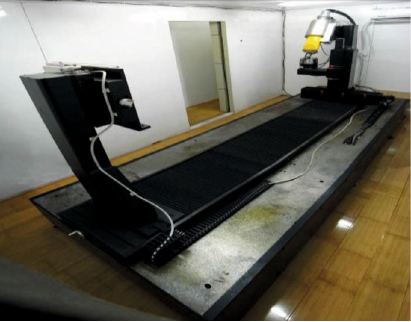
Figure 2: High-resolution micro-CT system.